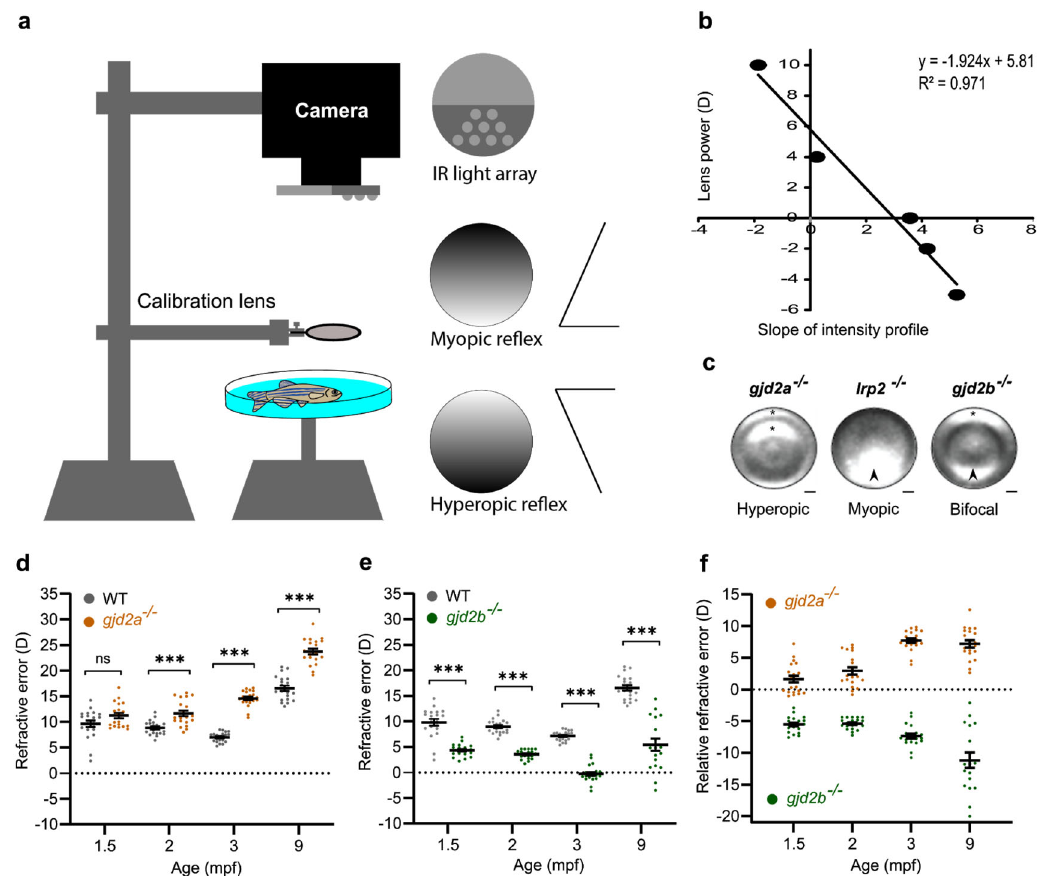
Fig. 2 Opposite refractive error in gjd2a (Cx35.5) and gjd2b (Cx35.1) mutants. a Schematic illustration of the eccentric photorefractor setup. b Calibration by − 6 diopter (D), − 2D, 0D, + 4D, and + 10D lenses led to a conversion factor of 1.924 ( R 2 = 0.971). c Typical intensity pro fi le of a hyperopic (asterisk) 3mpf gjd2a (Cx35.5) mutant and myopic (arrowhead) lrp2 mutant. The gjd2b (Cx35.1) mutant shows both myopic (arrowhead) and hyperopic (asterisk) contralateral features. d , e RE in the gjd2a (Cx35.5) ( d ) and gjd2b (Cx35.1) ( e ) mutants at 1.5 mpf, 2 mpf, 3 mpf, and 9 mpf. d Loss of Cx35.5 ( gjd2a ) results in a signi fi cant ( p < 0.001) and progressive hyperopic shift in refractive status. e Loss of Cx35.1 ( gjd2b ) is linked to a signi fi cant ( p < 0.001) and progressive myopic shift. f Mutant refractive status normalized against the baseline refraction of WT controls, indicated by the relative RE. Sample size: n = 20 eyes for each genotype and age. Error bars: SEM. Signi fi cance: ns = not signi fi cant, * p < 0.05, ** p < 0.01, *** p < 0.001. Scale bars: 50 µ m ( c ). RE refractive